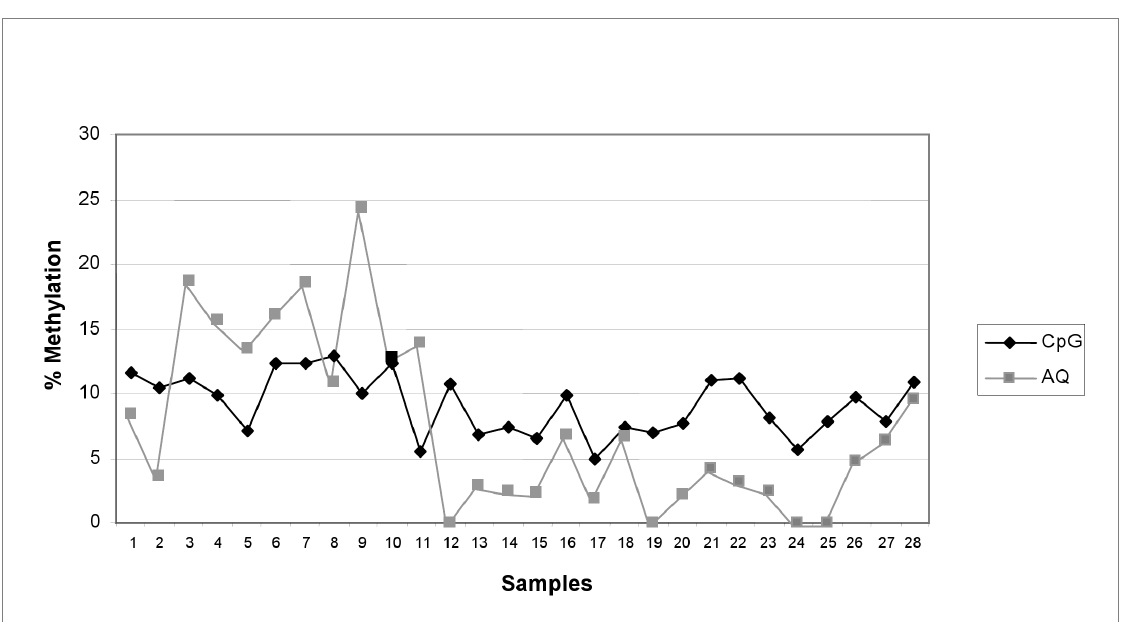
Fig 2. MGMT methylation analysis of DNA samples (DD study) tested in duplicate onto PyroMark CpG mode and AQ mode. DNA samples (N = 28) obtained buffy coats of patients involved in “ DD study ” [25]. Mean methylation percentage of 6 CpGs in the promoter of MGMT gene is reported. Target sequence: 194 bp of MGMT (Gene ID 4255 at position 44526 – 44719); CpGs at position 44600, 44604, 44607, 44614, 44621, 44623. Deviation between paired samples ranged from 0.3 to 14.4%. The CpG mode assigned 14 red score. No sample has a red score assigned by the AQ